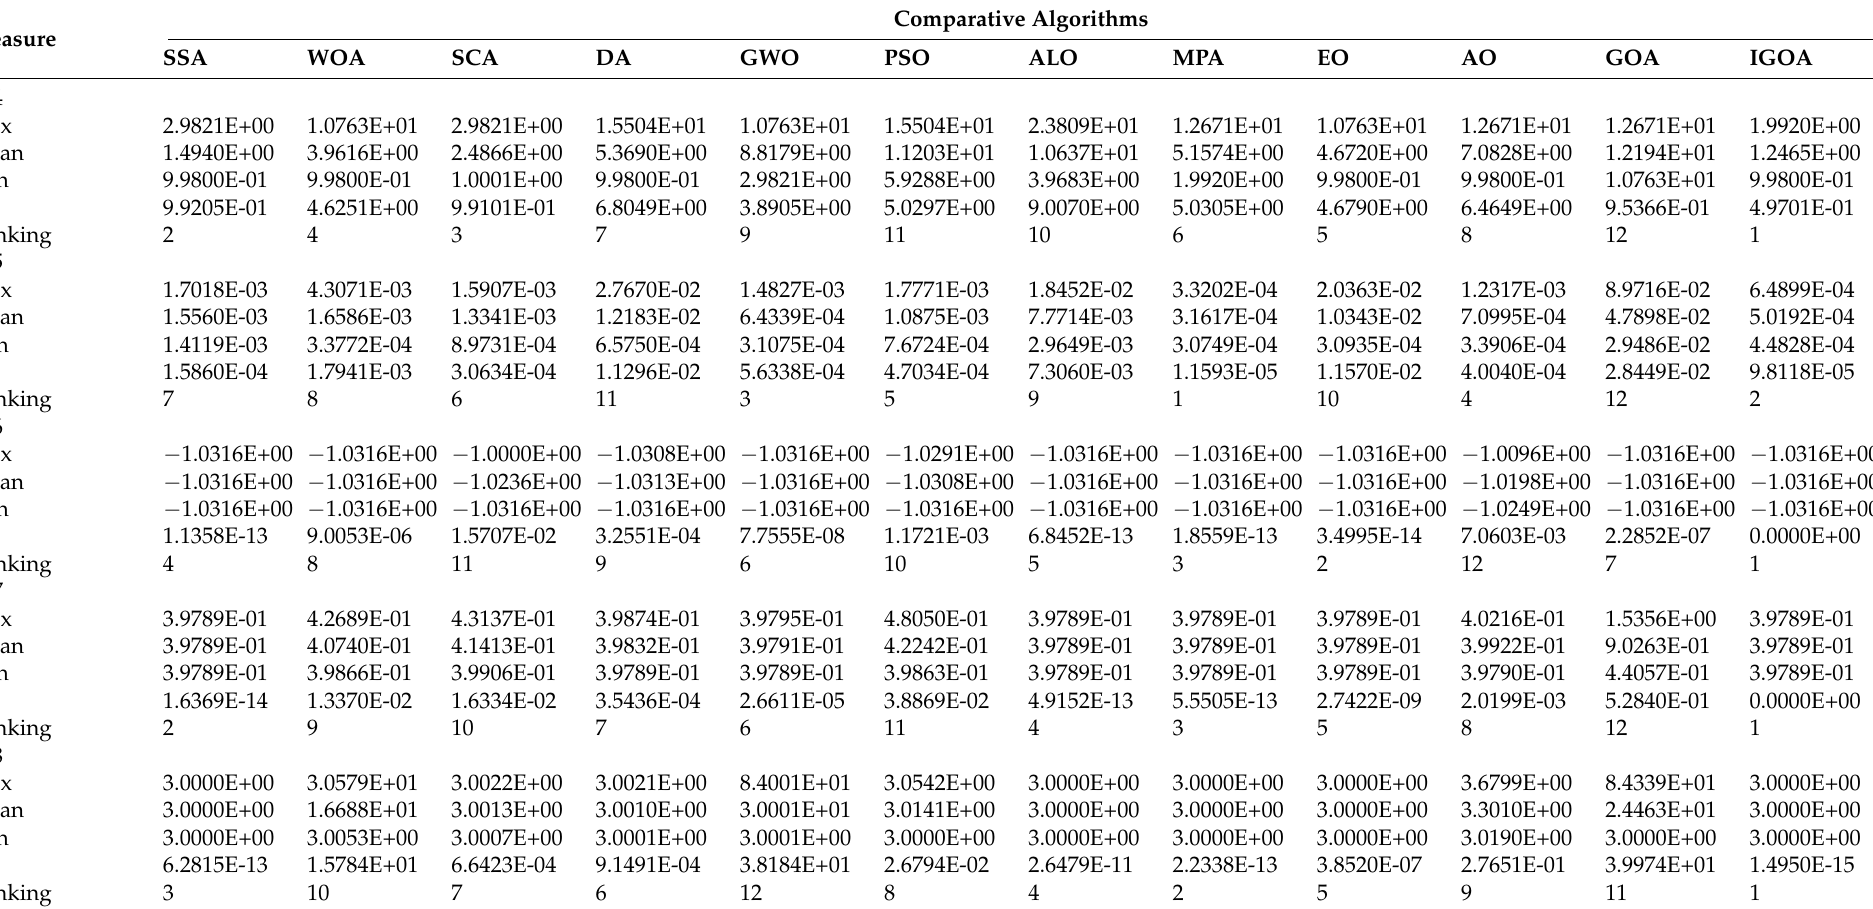
Table 5. The results of the proposed IGOA and other comparative methods using classical benchmark functions (F14–F23), where the dimension size is a fixed